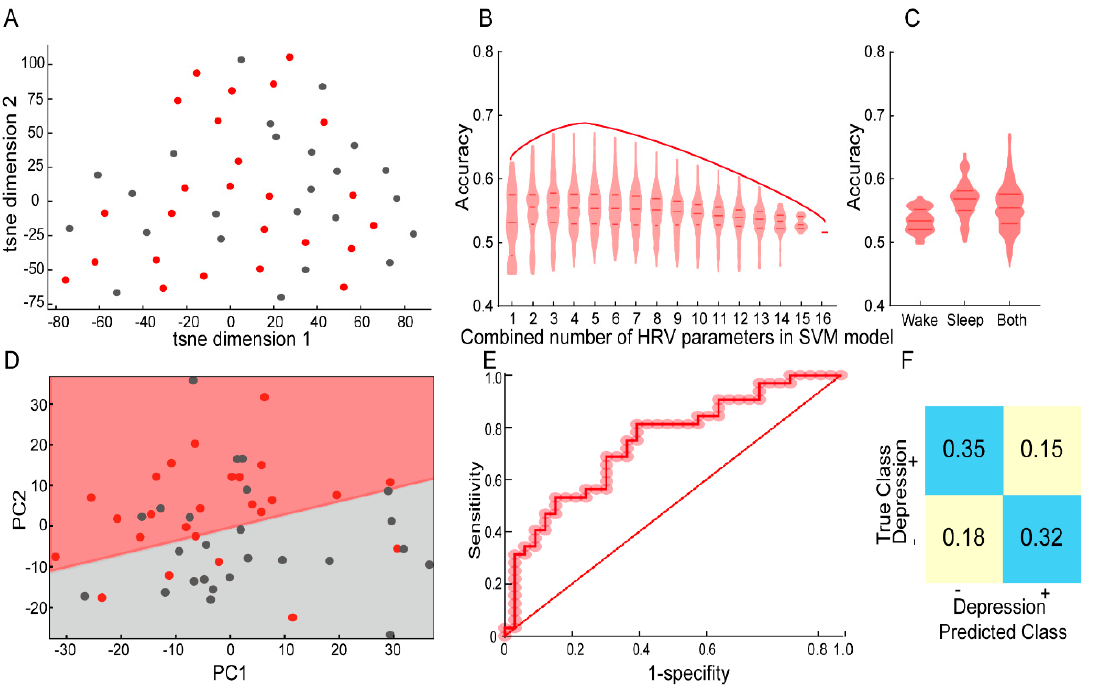
Figure 3. HRV parameters, particularly during NREM sleep, are capable of classifying PwE with and without depression. ( A ) A t − distributed stochastic neighborhood embedding (t − SNE) for classifying PwE with/without depression based on HRV parameters. ( B ) Computing the accuracy of all possible combinations of HRV parameters through a linear support vector machine (SVM) model, high degree classification accuracy distributed mainly in the combination of 4 parameters. ( C ) Computing accuracy in wakefulness and NREM sleep stage, highest accuracy was achieved while parameters involved both wakefulness and NREM sleep stage. ( D ) SVM decision boundary showed in a principal component analysis (PCA) space. ( E ) ROC curve for the model accuracy prediction, the model accuracy estimate fit the data at an acceptable level (Hosmer − Lemeshow test, p = 0.5676) and the area under the ROC curve was 0.7576. ( F ) Prediction confusion matrix for the selected optimal model. The red and gray dots in ( A , D ) representing PwE with and without depression state, respectively. PwE − people with epilepsy.